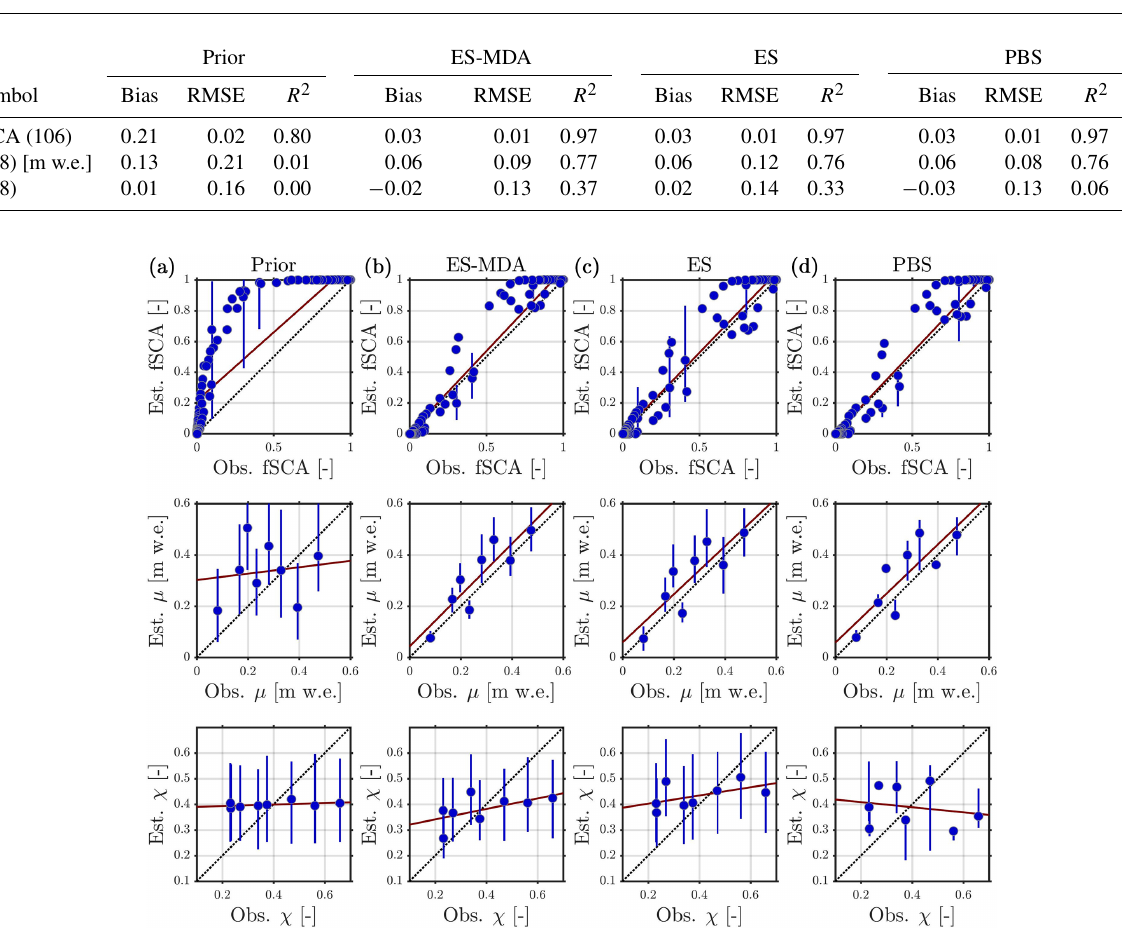
Figure 6. Scatterplots of the prior median (column a ) as well as ES-MDA ( N a = 4; column b ), ES (column c ) and PBS (column d ) posterior median estimates of fSCA (top row), peak mean SWE µ (middle row) and peak subgrid coefficient of variation χ (bottom row) versus the observations (field measurements); error bars: 90th-percentile range; all DA schemes were run with 10 2 ensemble members; one to one: dotted black line; linear best fit: solid red line. These results are from a single